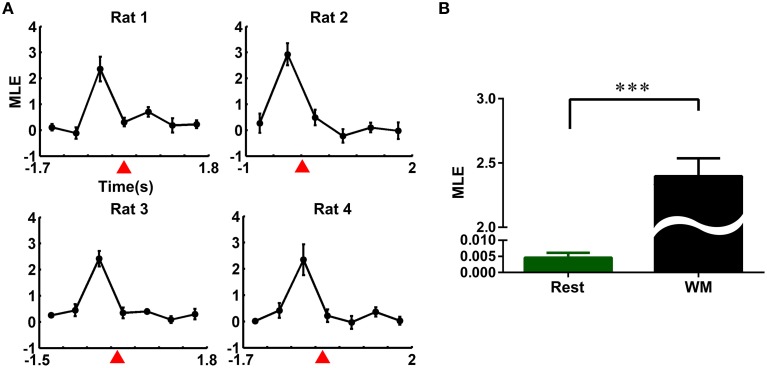
Evolution of the maximal Lyapunov exponent (MLE) of neural trajectories during the working memory task. (A) Changes of the MLEs during the working memory task in the correct trials (averaged over 10 trials for each rat). (B) MLEs in working memory and resting state. The MLEs in working memory state were significantly higher than those in resting state (averaged over 40 correct trials from four rats, ***P < 0.001).